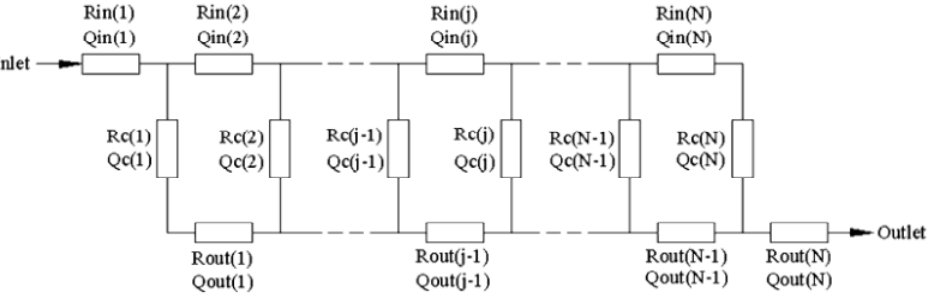
Figure 19. Microdevice design and the equivalent electrical resistance model. Reproduced from